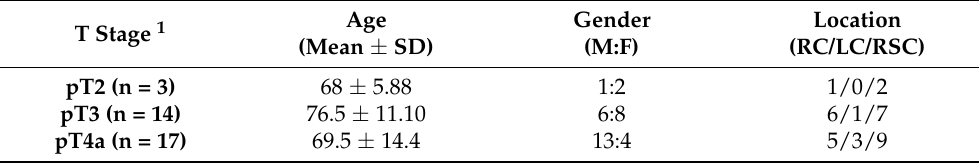
Table 1. Clinicopathologic characteristics of the patients included in the study.